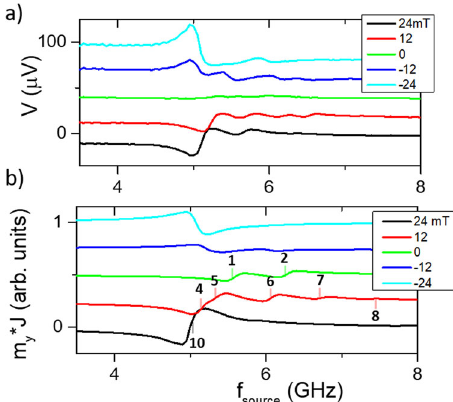
Fig. 4 Recti fi cation of higher-order modes. a Experimental recti fi ed voltage, V , and b the product of the magnetization along the y -axis, m y , and the applied current density, J , as found with micromagnetic simulations as a function of excitation frequency, f source , for different static in-plane magnetic fi elds. The y -axes are offset by 20 µ V